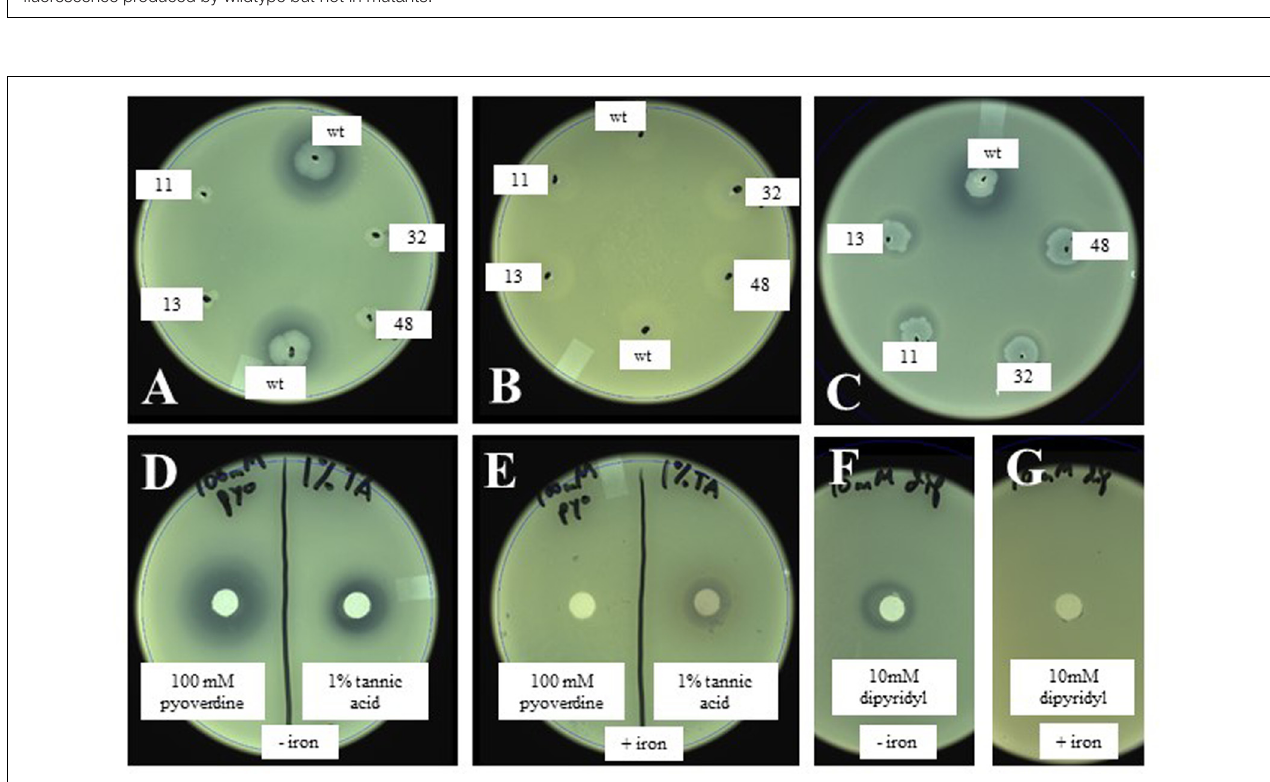
FIGURE 5 | Effect of wildtype and mutant P. putida KT2440 (A,B) and of the chelating agents pyoverdine and tannic acid (D,E) on X. fragariae growth in WBN overlays without (A,D) or with (B,E) supplemented iron (1.4 mM FeSO 4 ). Also shown is the complementation of KT2440 mutant colonies with 5 µ l each of 1 mM pyoverdine (C) , as well at the effect of the chelator dipyridyl on X. fragariae growth in the absence (F) or presence (G) of supplemental iron (1.4 mM FeSO 4 ). Wild-type KT2440 is labeled as ‘wt’; the four Tn 5 insertion mutants 17A11, 13C08, 32C04, and 48E07 as 11, 13, 32, and 48, respectively. Pyoverdine (D,E) , tannic acid (D,E) or dipyridyl (F,G) were added to a filter paper on the agar surface as 5 µ l of a 100 mM, 1% (5.9 mM) or 10 mM stock solution, respectively.